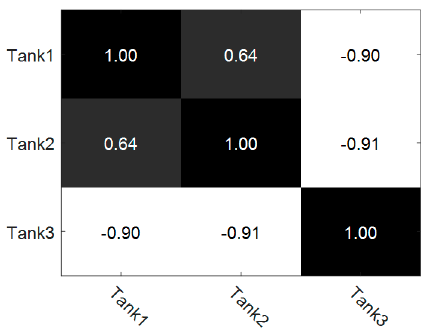
Figure 5. Correlation coefficients of three different tasks. The term ‘Tank1’ (‘Tank2’, ‘Tank 3’) denotes the task to classify tank 1 (tank 2, tank 3).